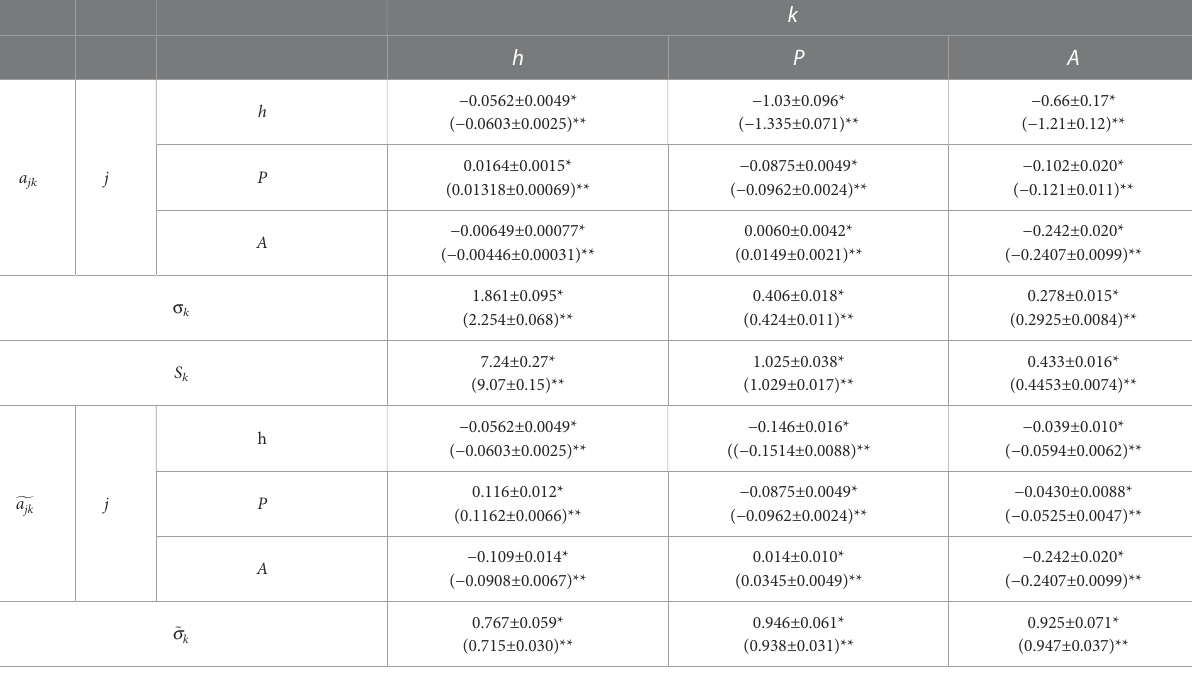
TABLE 4 Parameters(and 1-standard-deviation con fi dence intervals) obtainedbythe fi ttingwiththe three-variableReOsc+Atlantic-Paci fi c model (Eq. 1 fi tted as explainedinSection 2.3)for SODA (marked with*)and ORA-20C(with parenthesis, marked with**) reanalysis inthe 1971-2000 period.